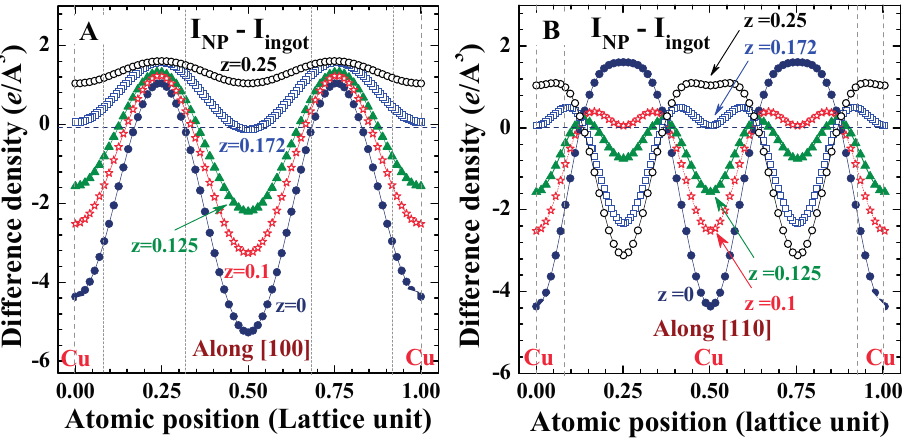
Figure 6. Difference of the electronic charge density between the 6.6 nm Cu assembly and 2 mm Cu ingot along the ( A ) (100) and ( B ) (110) crystallographic directions at z = 0 (filled circles), 0.1 (open stars), 0.125 (filled triangles), 0.172 (open squares), and 0.25 (open circles). The shaded areas indicate the regions of the inner cores.